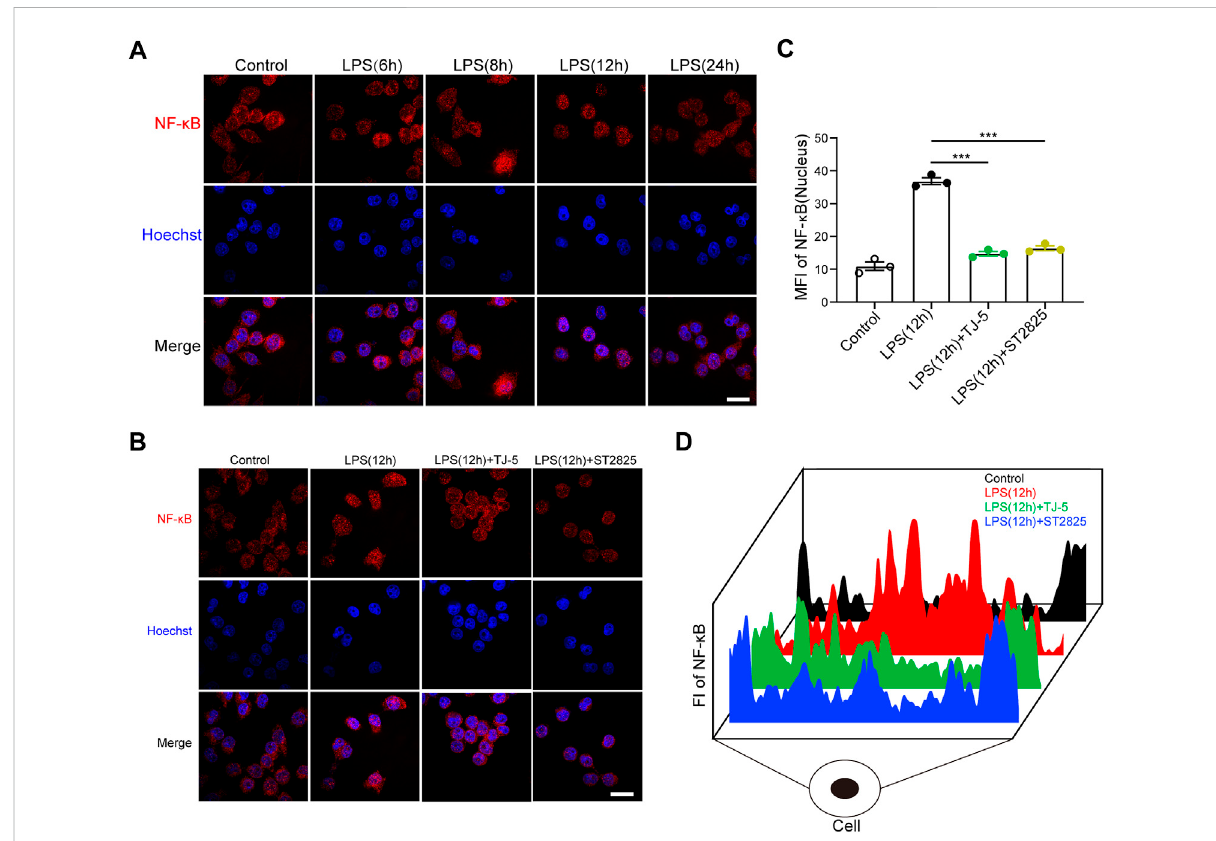
FIGURE 7 (A) Immuno fl uorescencewasused to determine theoptimalobservationtime point forNF- κ Bp65nucleartranslocationinLPS-stimulated BV- 2 cells (scale bar = 50 μ m). (B) After 12 h of LPS stimulation, immuno fl uorescence was used to analyze the effect of TJ-5 on NF- κ B p65 nuclear translocation in BV-2 cells (scale bar = 50 μ m). (C) The mean fl uorescence intensity (MFI) of NF- κ B p65 in the nucleus was statistically analyzed. (D) The distribution diagram of NF- κ B p65 in cells was obtained by detecting fl uorescence intensity (FI). All the experiments were repeated three times. Values are mean ± SEM. (*** p <